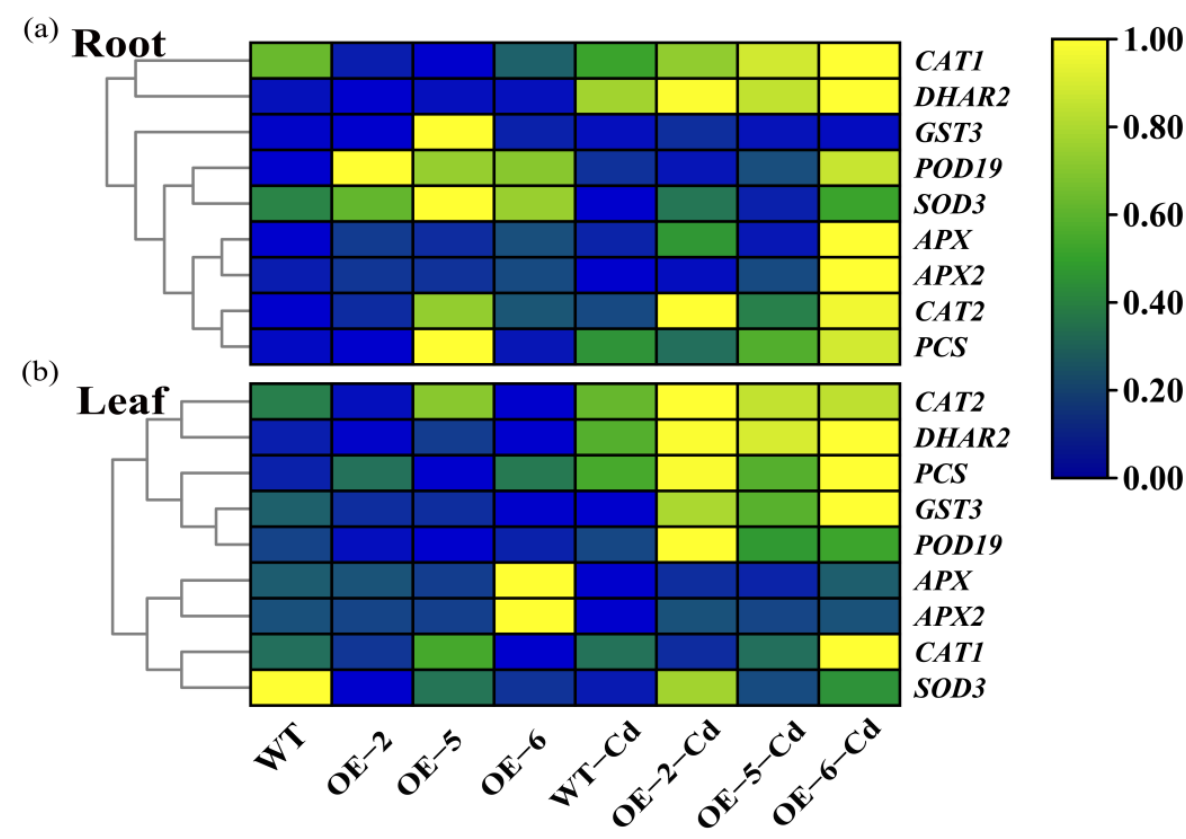
Figure 5. The expression level of key genes involved in the AsA–GSH metabolomic pathway in roots and leaves of SpHsfA4c -transgenic poplars and WT under 100 µ M CdCl 2 for 30 d. ( a ) Gene expression in roots; ( b ) gene expression in leaves.